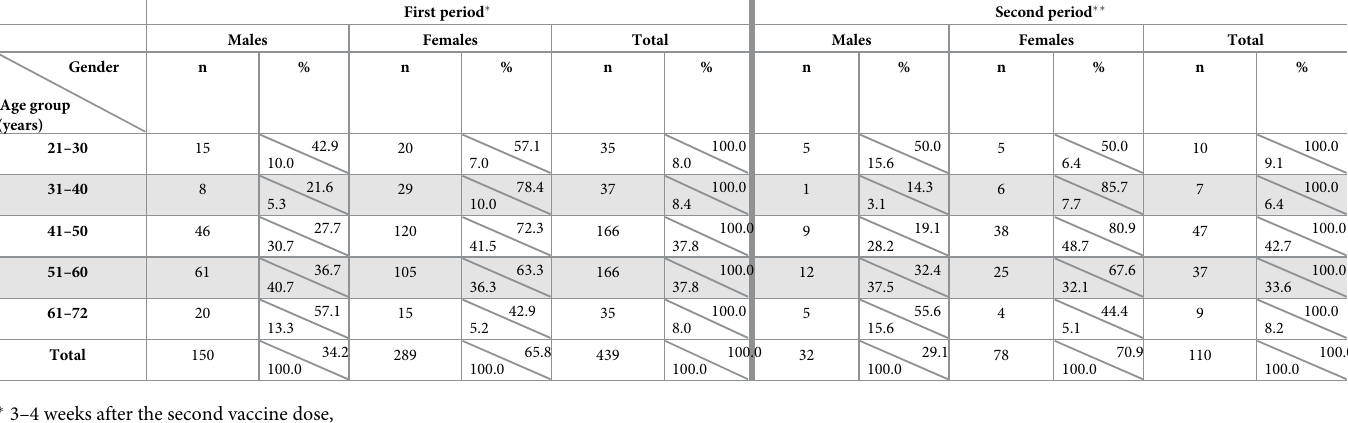
Table 1. Demographic features of participants during the two study